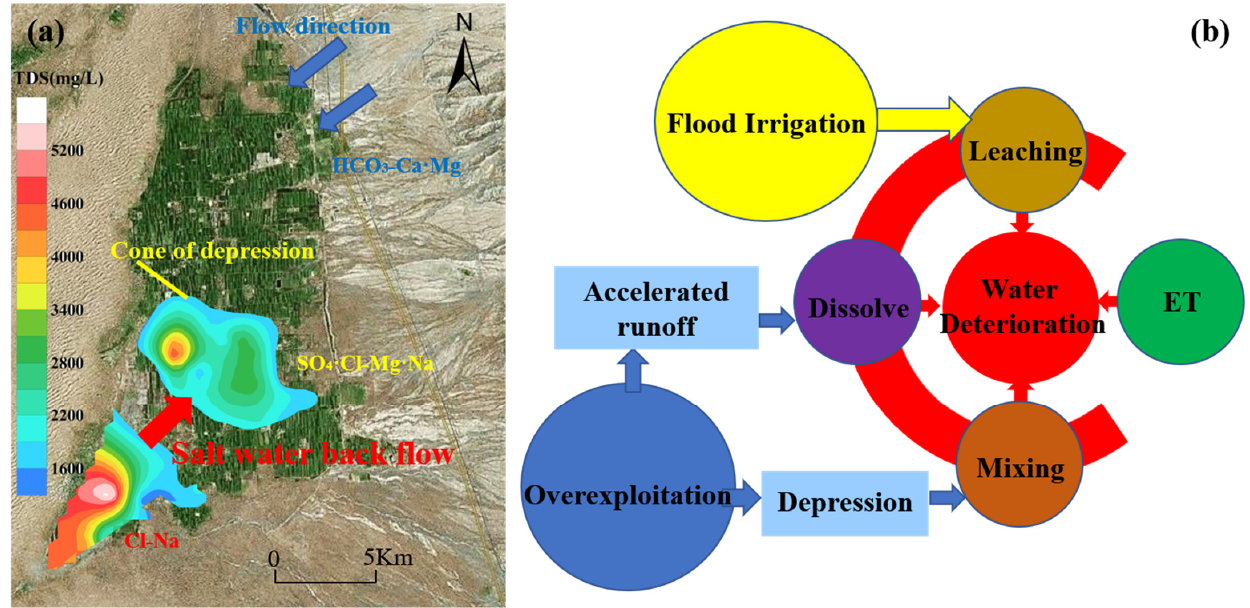
Figure 11. Process of salinization in groundwater of the Yaoba Oasis. ( a ) Groundwater degradation under salt water intrusion; ( b ) Groundwater hydrochemical response to overexploitation.